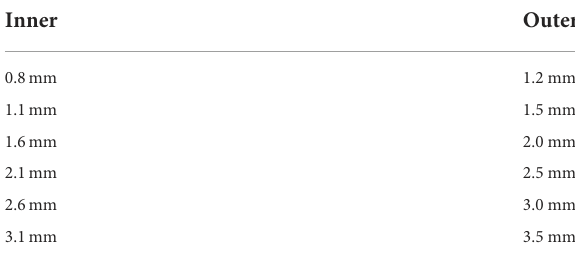
TABLE 1 Diameters of